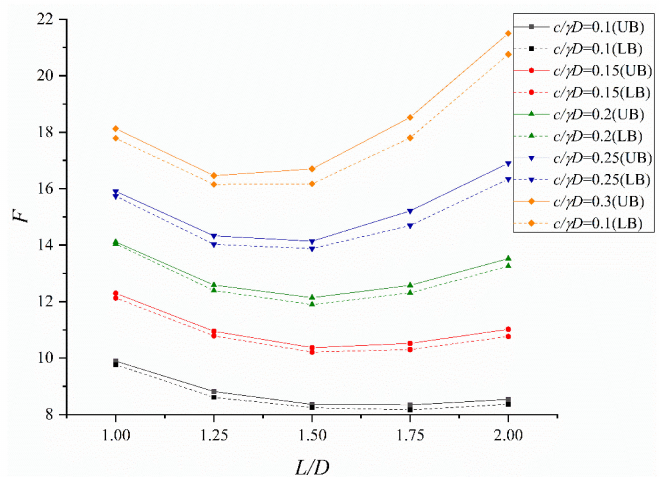
Figure 34. Influence of C/D on the safety factors F of the global stability of adjacent construction under different c/ γ D ( ϕ = 25 ◦ , L/D = 1).